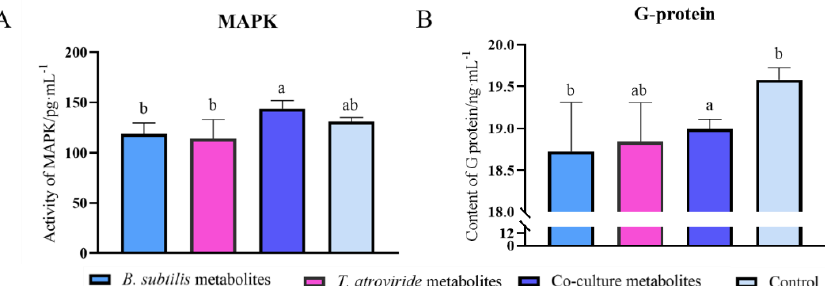
Figure 3. Impact of co-culture filtrate on the activity of ( A ) the mitogen-activated protein kinase and ( B ) G protein receptor 1 (GPR1). Data resulted from biological triplicate cultures with microplate reader technical duplicates. a, b, represent significant differences between the axenic and co-culture treatments ( p < 0.05)